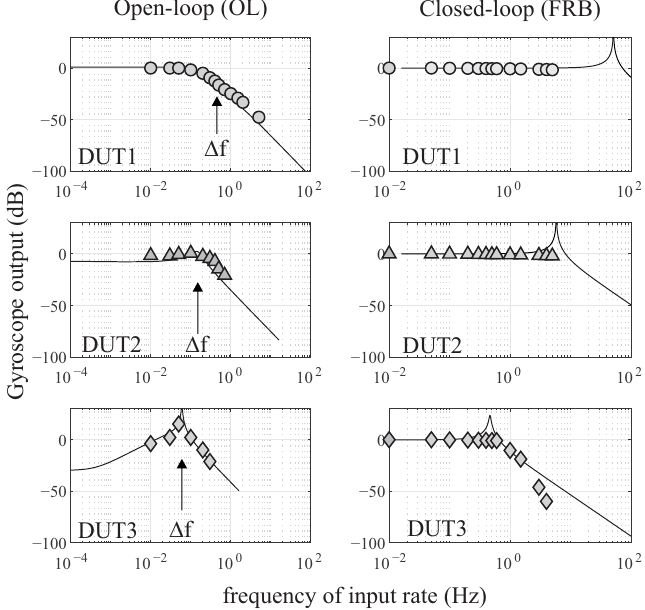
Figure 19. Simulation of the gyroscope bandwidth overlaid with experimental measurement points, operating in the open-loop ( first column ) and closed-loop ( second column ). Three devices with different Q-factors were used and each row represents one